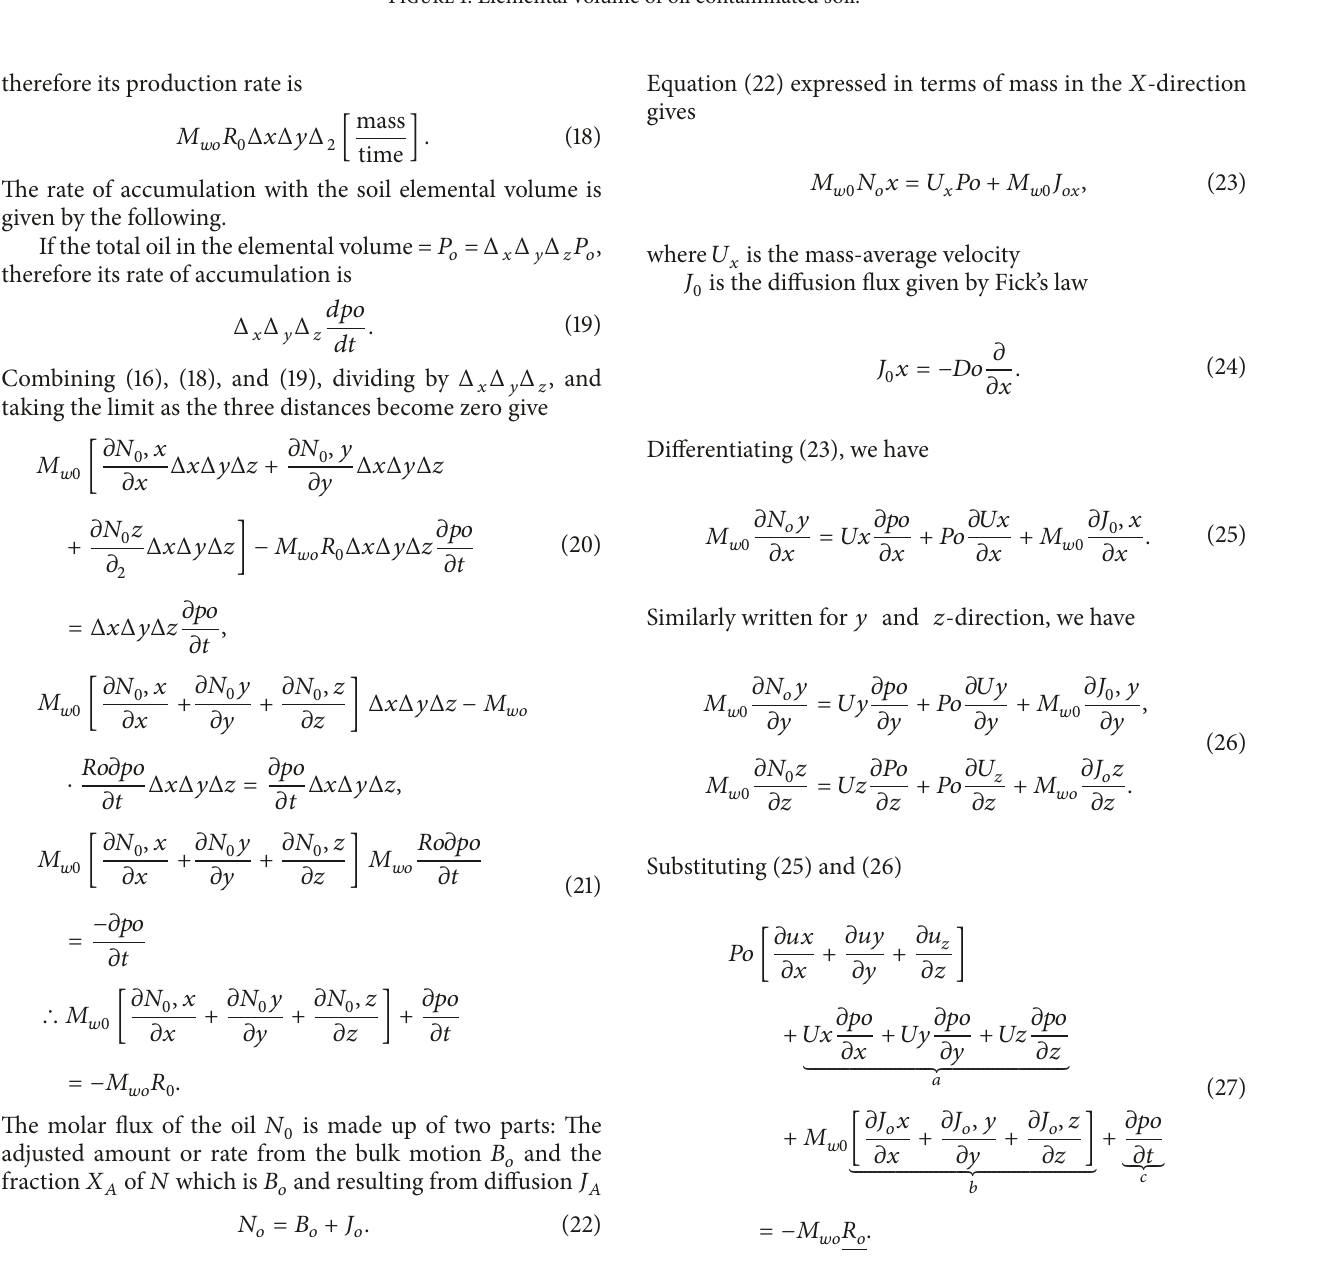
Figure 1: Elemental volume of oil contaminated